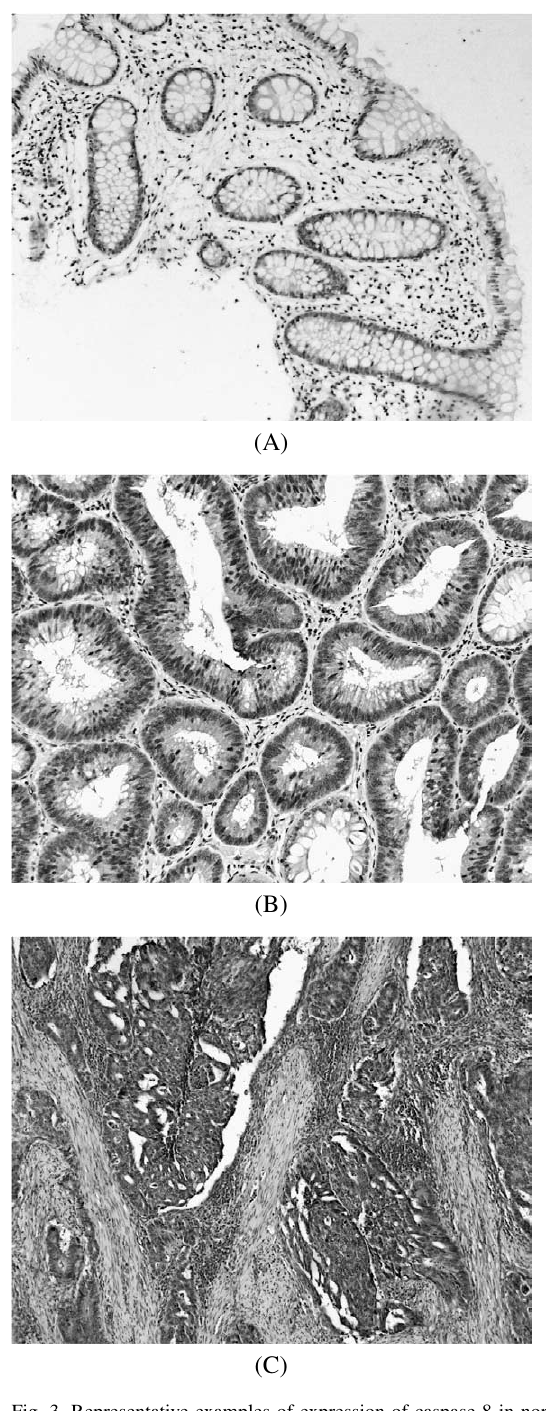
Fig. 3. Representative examples of expression of caspase-8 in nor- mal colon tissue, colorectal adenomas and carcinomas. Normal tis- sue showing negative cytoplasmic staining ( − ). (B) Adenoma show- ing strongly positive staining ( + ). (C) Carcinoma showing strong positive staining ( + ).